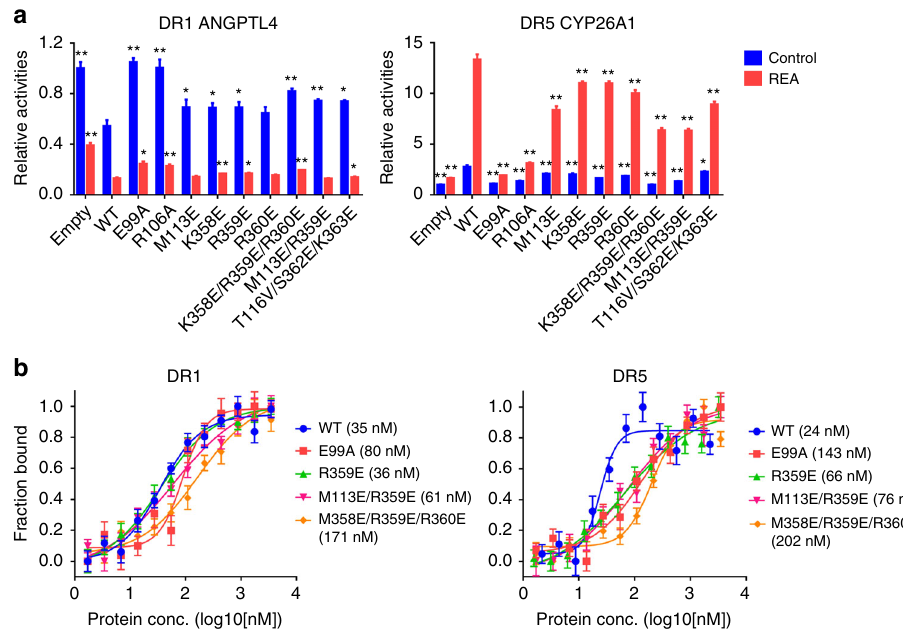
Fig. 3 Effects of mutations at RAR β DBD – LBD interface on the transcription and DNA binding of RAR β – RXR α heterodimer. a Functional reporter assays testing the transcriptional activities of RAR β – RXR α . The wide-type (WT) RAR β and its mutants (majority at the interface) were tested for their transactivation on DR1 ANGPTL4 (left) and DR5 CYP26A1 (right) reporters, in the absence or presence of 1 μ M REA. Each sample represents the average reading of cells from three wells, and data are shown as mean ± SD. The statistical differences between mutants (or the empty vector) and corresponding WT were calculated using the two-tailed t -test (* P < 0.05; ** P < 0.01). b DNA-binding af fi nities of RAR β – RXR α heterodimer (WT and RAR β mutants) to DR1 DNA (left) and DR5 DNA (right) measured in the presence of REA and 9CR at 3× concentrations. K D values are in parentheses. The data points are plotted as mean ± SD from three technical replicates